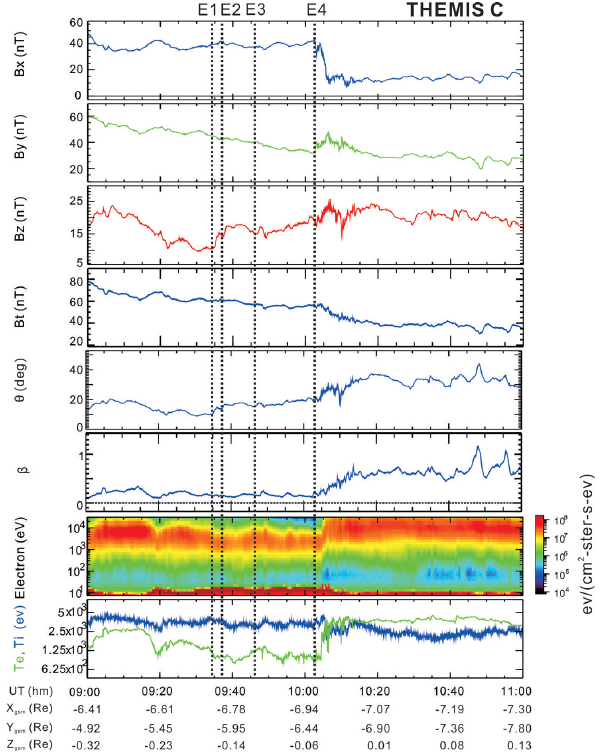
Fig. 7. Summary plots of THEMIS B’s observations between 09:00UT and 11:00UT on 5 December 2008: the three components of the magnetic field in GSM coordinate, the total magnetic field, plasma β , energy spectra of 0.005–300keV electrons from the SST and ESA instruments, and the ion and electron temperature. perature from 09:00 UT to 11:00 UT on 5 December